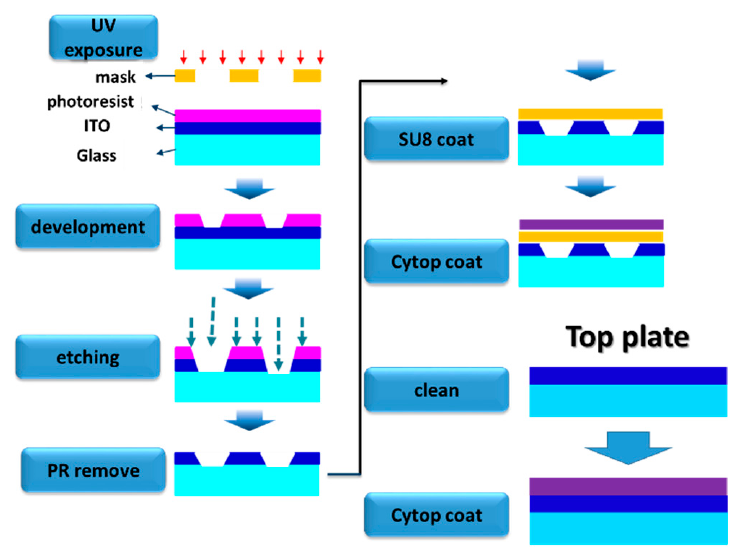
Figure 4. EWOD and DEP chip fabrication flow.